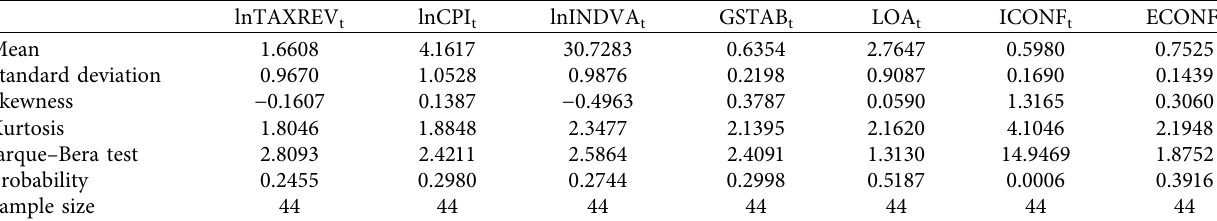
Table 2: Descriptive statistics.